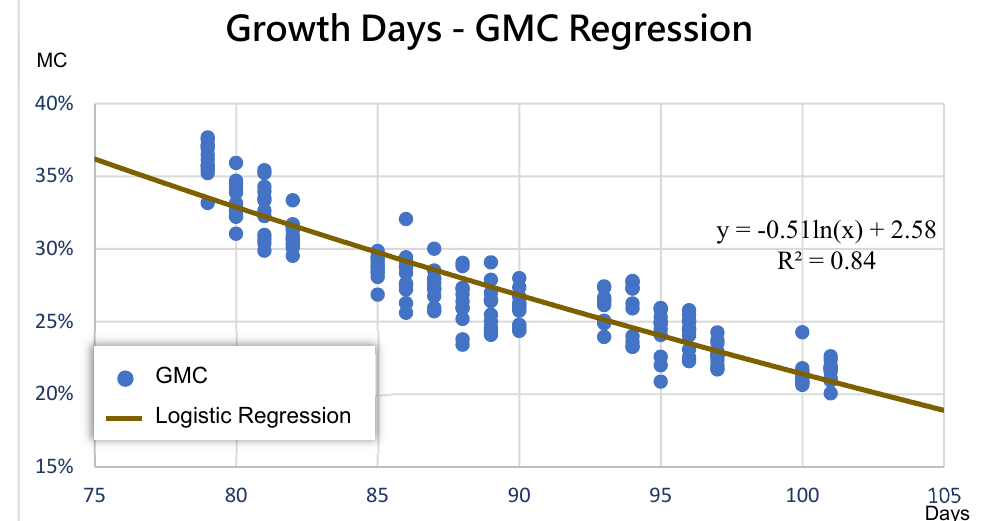
Figure 17. Data distribution and logistic regression of the growth days and GMC.